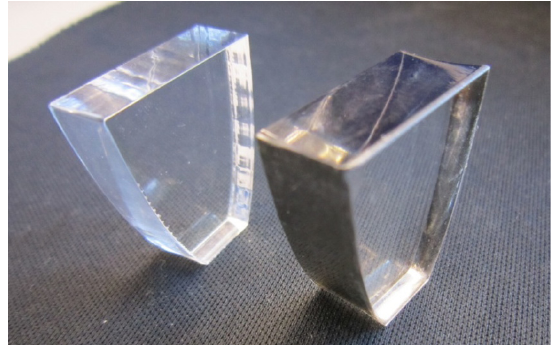
Figure 3. A photograph of the solid dielectric CPC module with and without